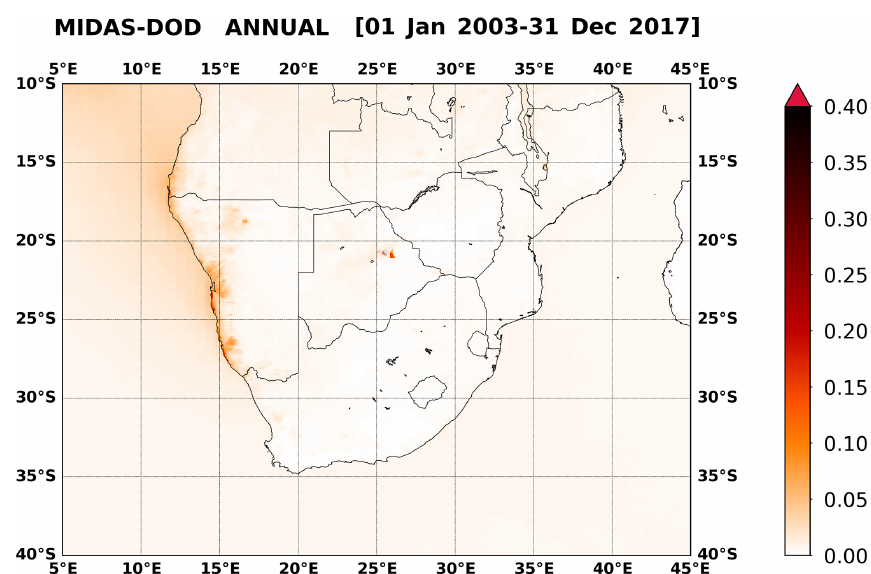
Figure 8. As in Fig. 1 but for southern Africa.